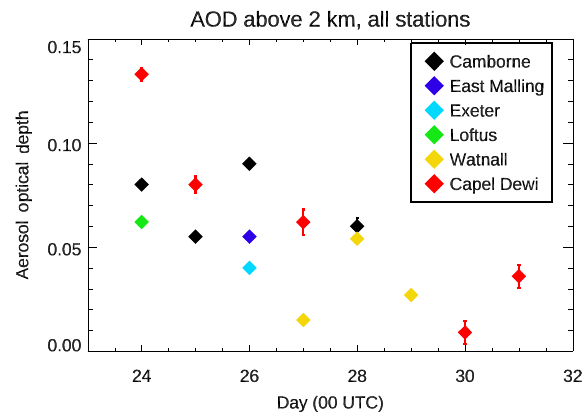
Figure 7. Total aerosol optical depth measured above 2km by the Raman lidars during the last 8 nights of May 2016, expressed as whole-night averages. The Capel Dewi points are those calculated using the Camborne